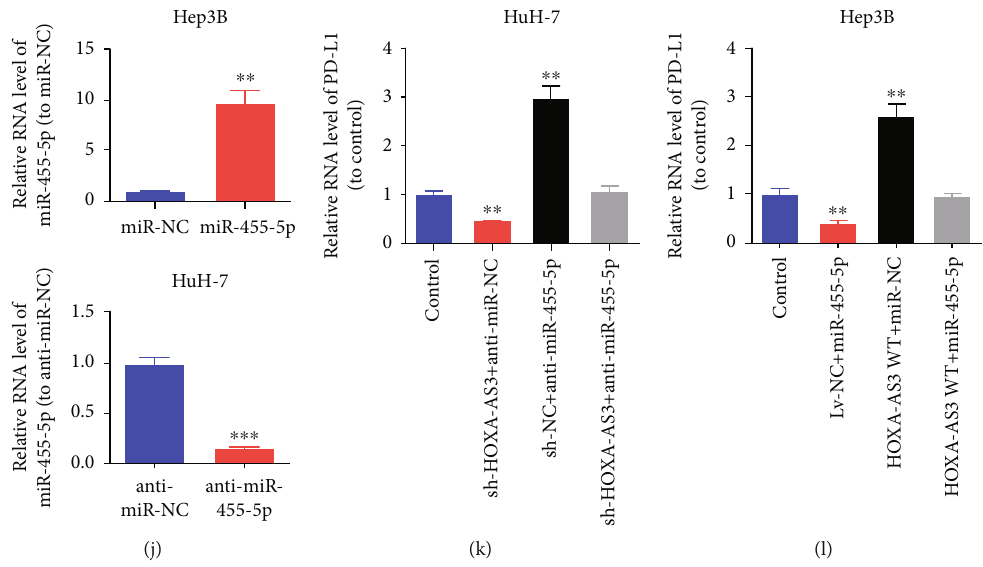
Figure 4: HOXA-AS3 enhances PD-L1 expression via binding to the 3 ′ -UTR of miR-455-5p. (a) Typical images of the subcellular localization of HOXA-AS3 in Hep3B cells as shown by RNA-FISH. (b) Association between HOXA-AS3 expression and PD-L1 expression in HCC cells evaluated by Pearson ’ s correlation analysis. (c, d) E ff ects of HOXA-AS3 overexpression or knockdown on PD-L1 expression in HCC cells. (e) Bioinformatics analysis by using starBase. (f) Levels of miR-455-5p and PD-L1 in HCC cells. (f – i) Dual-luciferase reporter assay with binding sites. (j) E ff ects of miR-455-5p mimics or inhibitor on miR-455-5p expression in HCC cells. (k) E ff ects of anti-miR-455-5p and HOXA-AS3 shRNA on PD-L1 expression in HCC cells. (l) Overexpression of a fragment of HOXA-AS3 carrying the MRE of miR-455-5p could reverse the inhibition of PD-L1 expression induced by overexpressed miR-455-5p. Data are reported as the mean ± SD of three separate experiments. ∗ P < 0 : 05 , ∗∗ P < 0 : 01 , and ∗∗∗ P < 0 : 001